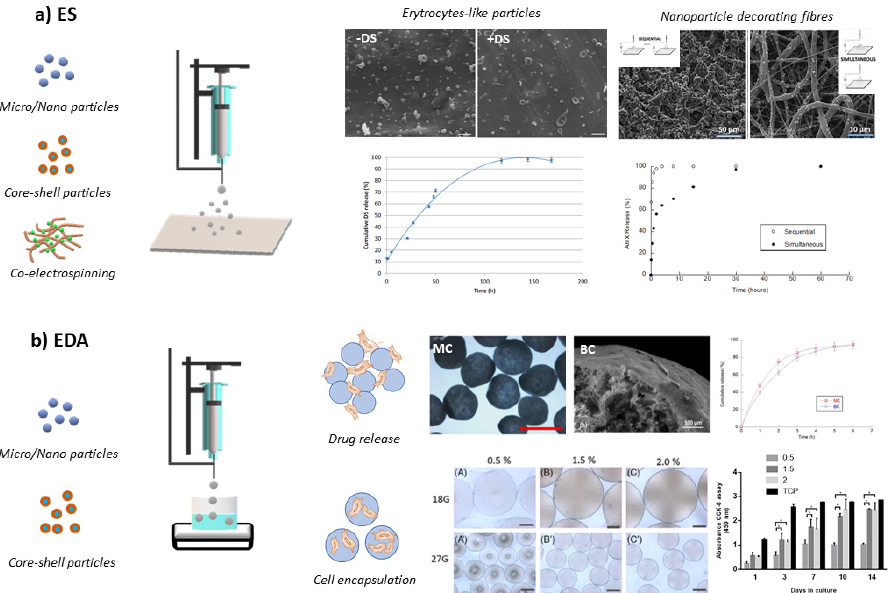
Figure 7. EFDTs for the fabrication of micro- and nano-devices. ( a ) electrospraying (ES): diclofenac- loaded (DS) erythrocyte-like nanoparticles—effect of DS on particle morphology and release profile (adapted from [110]); nanoparticle decorated fibers via co-electrospinning (i.e., simultaneous or sequential mode) for the development of fibrous platforms with different release of antibiotics from chitosan nanoparticles (adapted from [111]). ( b ) Electrodynamic technique (EDA): drug-loaded cellulose carriers with different compositions—i.e., mono-component (MC) or bi-component (BC) and effects on morphology and release profiles (adapted from [112]; alginate microgels for cell carrier/encapsulation—effect of polymer concentration on morphology and in vitro cell response (adapted from [113]).